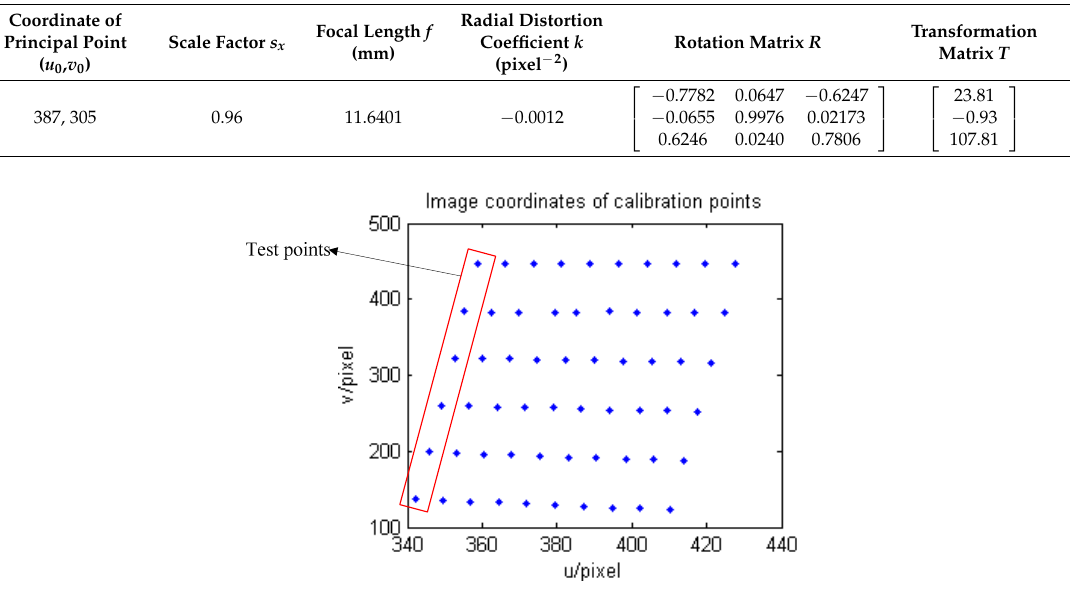
Table 1. Calibration result of the normal camera model.